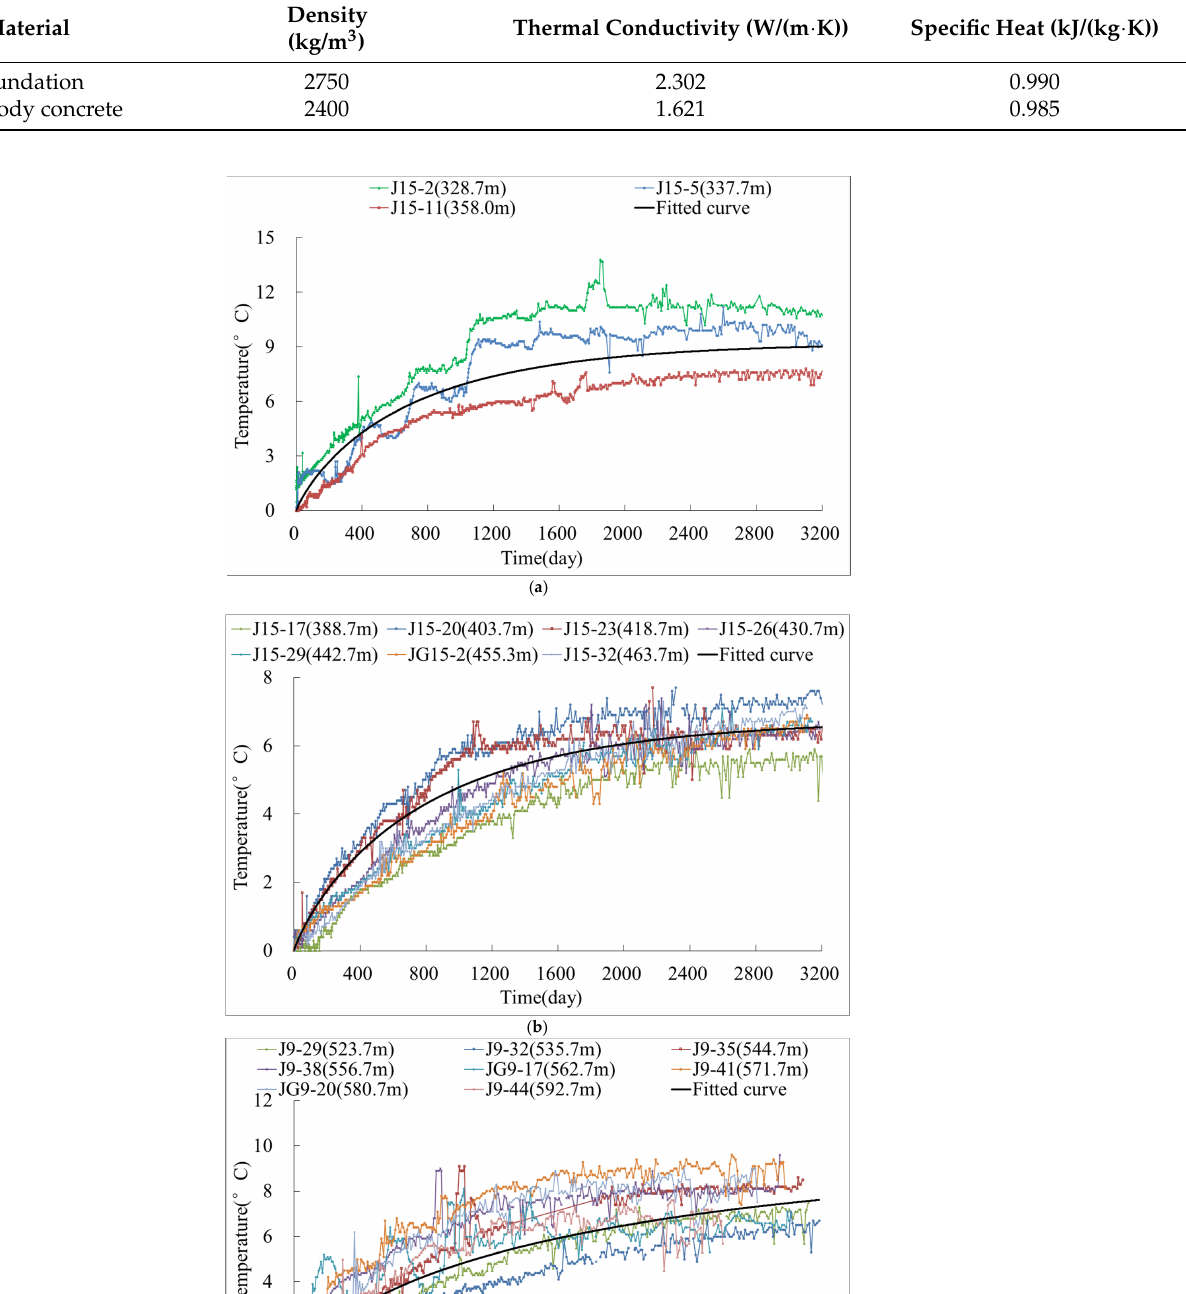
Table 5. Thermal parameters of dam body and foundation.